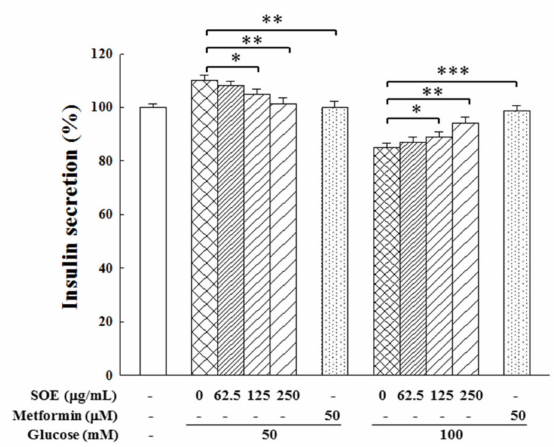
Figure 5. Effect of SOE on insulin secretion in RIN-m5f β -cells under HG induction. The β -cells were cultivated at a density of 5 × 10 5 cells/well for 24 h, and then the specified concentration of SOE was added under the stimulation of 50 mM or 100 mM glucose. After 24 h treatment, the cell solution was replaced by Krebs–Ringer buffer and conducted the insulin secretion measurement by Rat/Mouse Insulin ELISA Kit. The experimental data were calculated from the results of five repeated experiments. The statistically significant differences compared with the vehicle (group 0) are expressed as * p < 0.05, ** p < 0.01, and *** p < 0.001. The positive control was 50 µ M